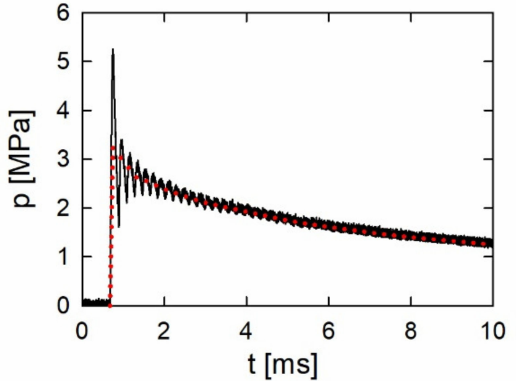
Figure 5. Comparison of filtered (solid line) and smoothed (dotted line) pressure courses.